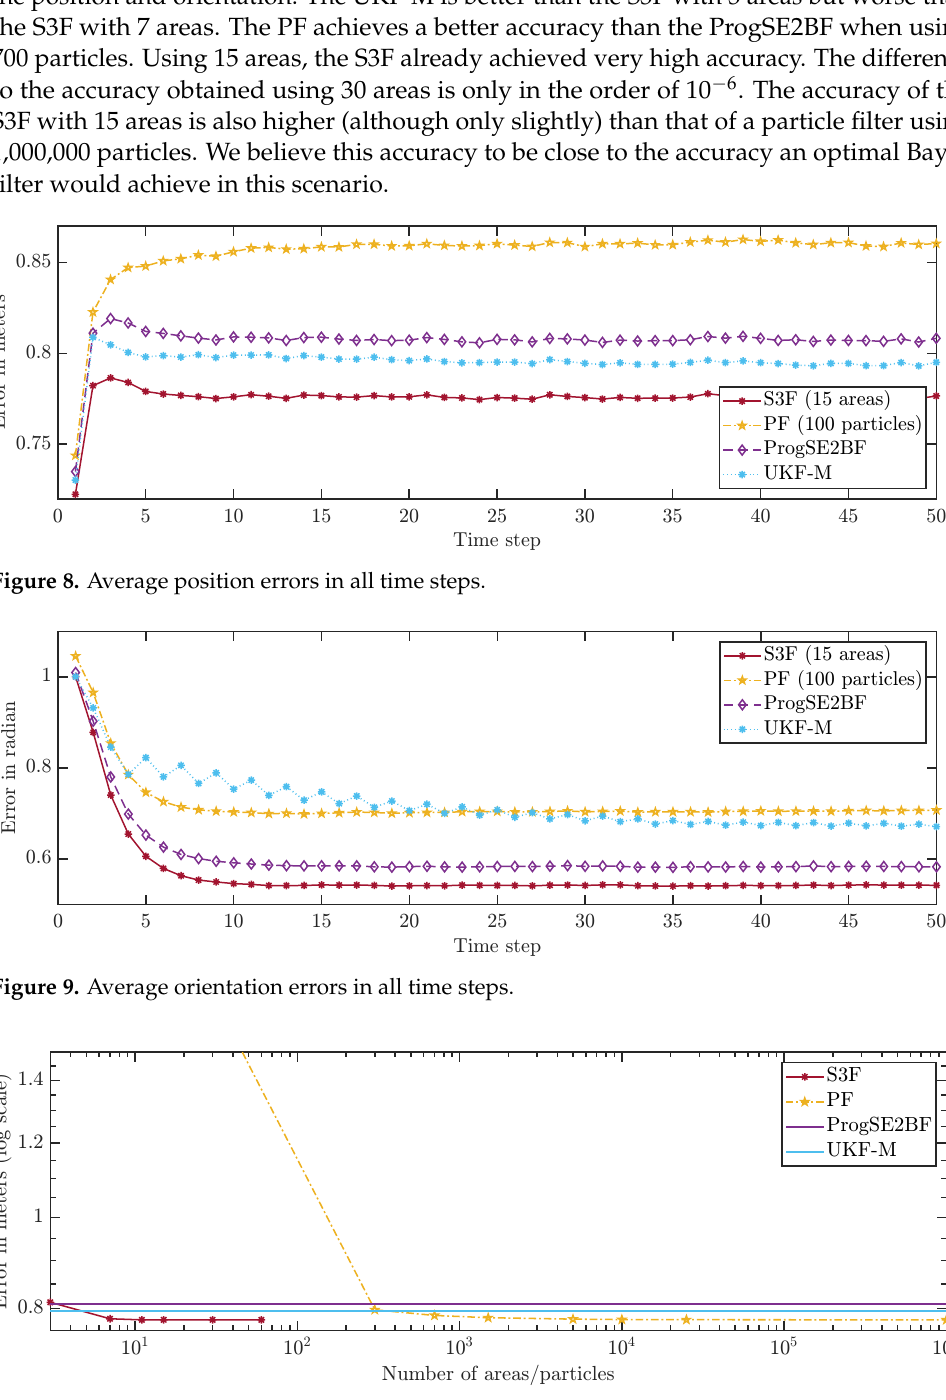
Figure 10. Position error over number of areas or